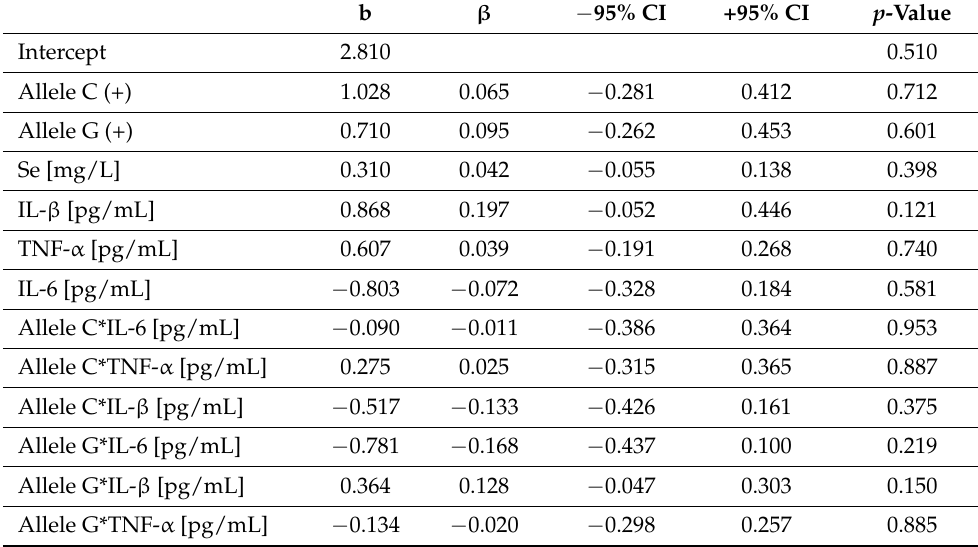
Table 16. Model II with moderation by the